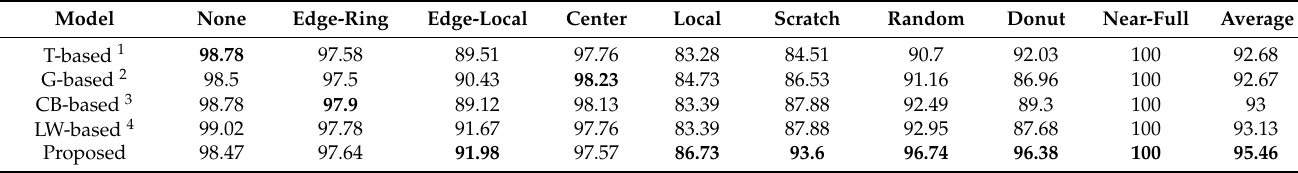
Table 4. Comparison with other imbalanced dataset processing methods